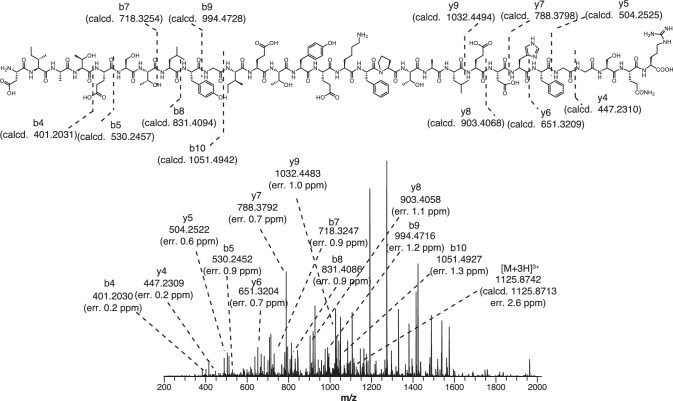
HR-ESI-MS/MS of the tryptic peptide from Methanosarcina acetivorans McrA (Asp392-Arg421, m/z 3375 Da) present in the wild-type and ∆ycaO-tfuA, ∆tfuA, ∆ycaO deletion strains.Predicted masses and associated errors are shown.